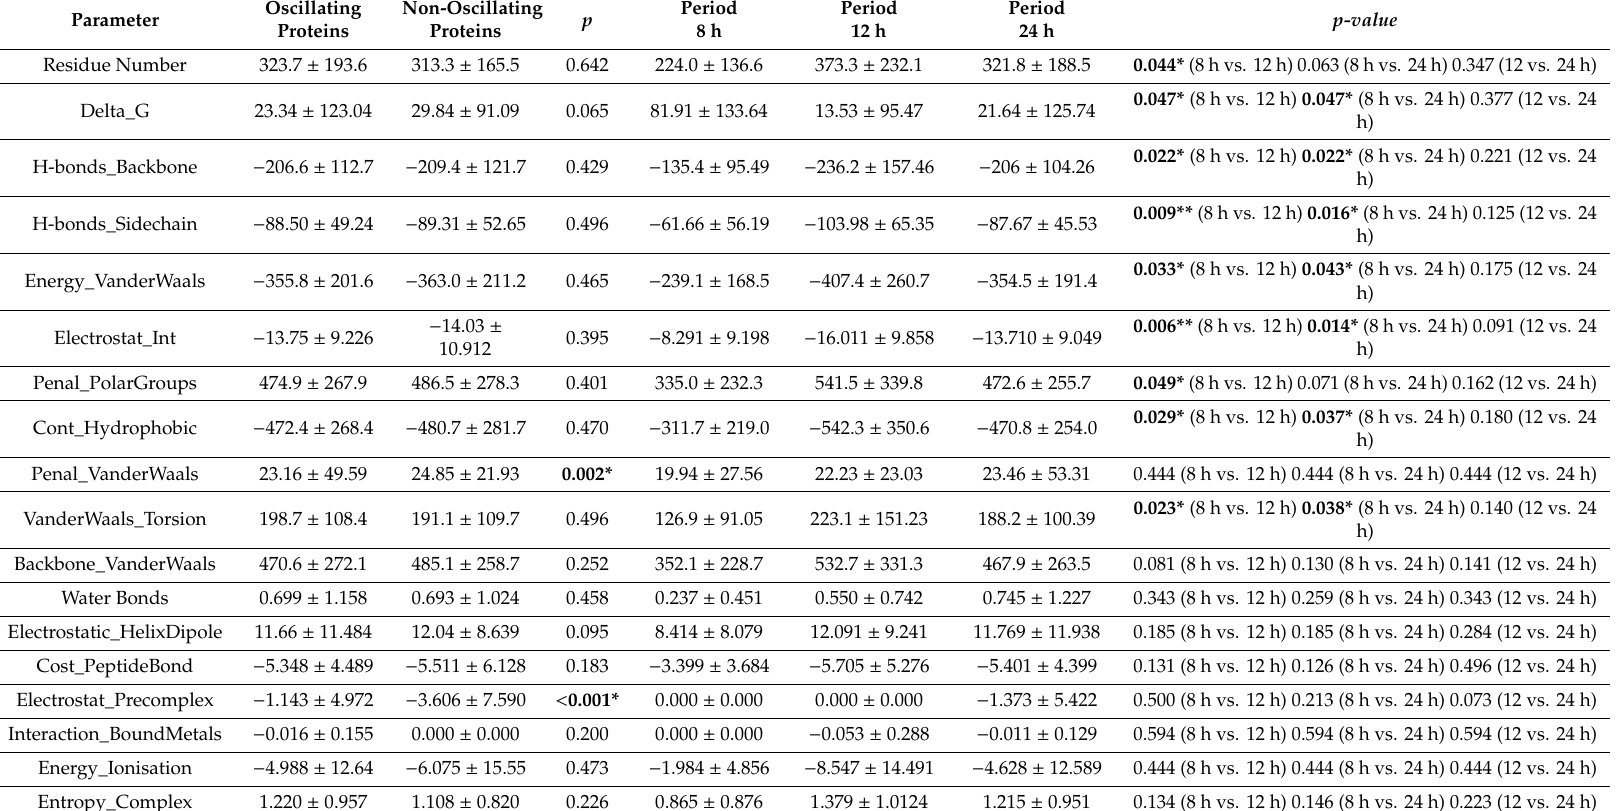
Table 1. Descriptive statistics of energy values as from the FOLD-X energy function (mean ± SD) and results of Kruskal–Wallis one-way analysis of variance with Residue Number as covariate and Dunn’s post hoc test with false discovery rate (FDR)